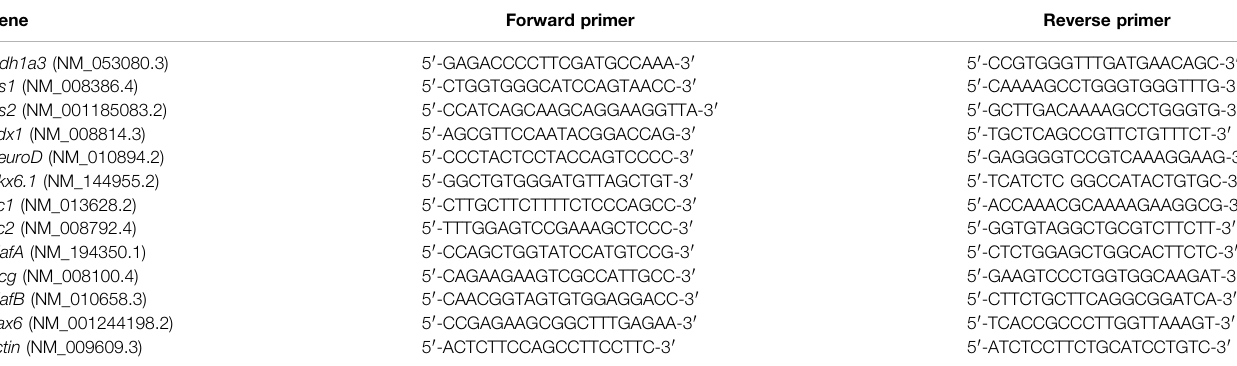
TABLE 1 | The primer list of genes for